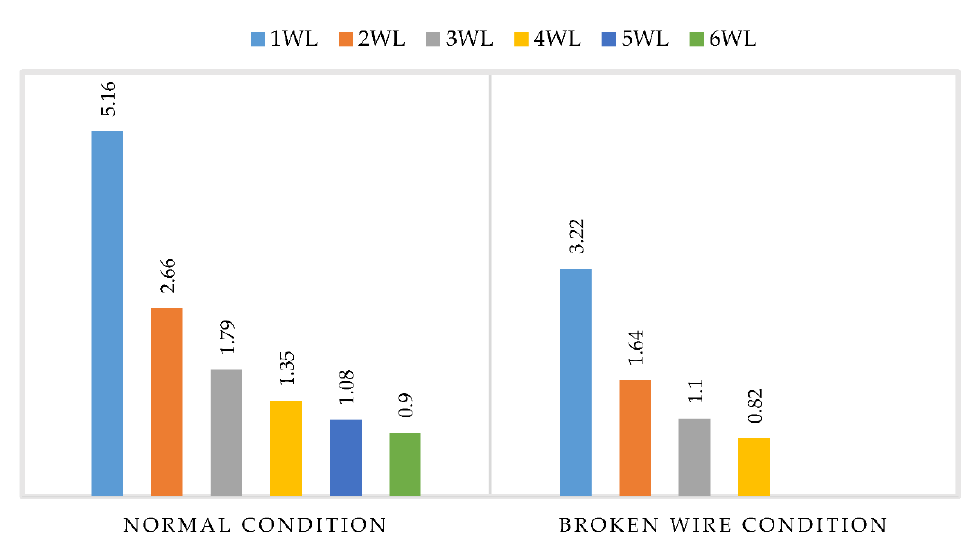
Figure 11. Comparison Factor of Safety (FOS) for normal and broken wire condition.